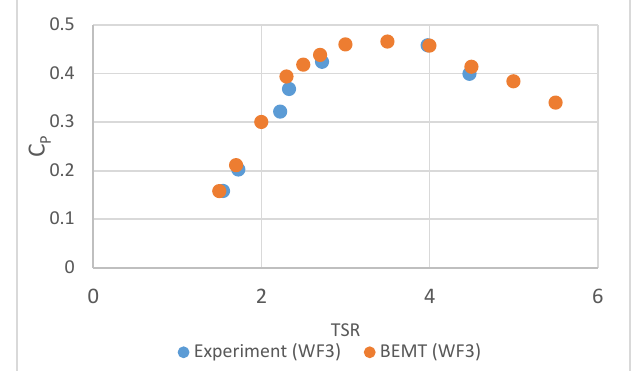
Figure 6. C T comparison between BEMT and experiments undertaken at Ifremer for the 0.5 m/s case when the turbine operated under wave-current interactions with a wave height of approximately 0.2m and a wave period of 1.7s.